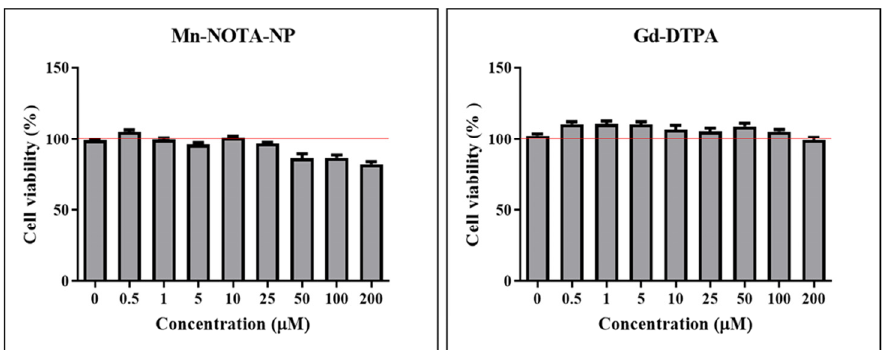
Figure 3. In vitro cell viability of RAW 264.7 cells with different concentrations of Mn-NOTA-NP and Gd-DTPA at 37 °C for 24 h. Data are represented as mean ± SEM (standard error of the mean) and n = 3. The red line represents the control value.